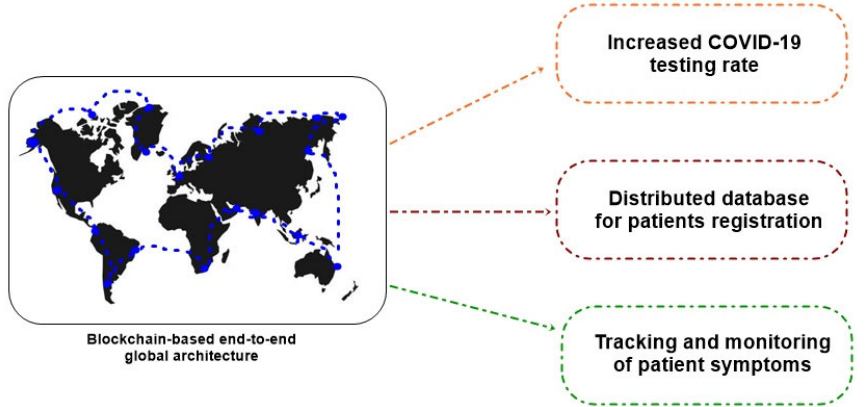
Figure 2. COVID-19 impact management using Figure 2. COVID ‐ 19 impact management using blockchain. Figure 2. COVID ‐ 19 impact management using blockchain.